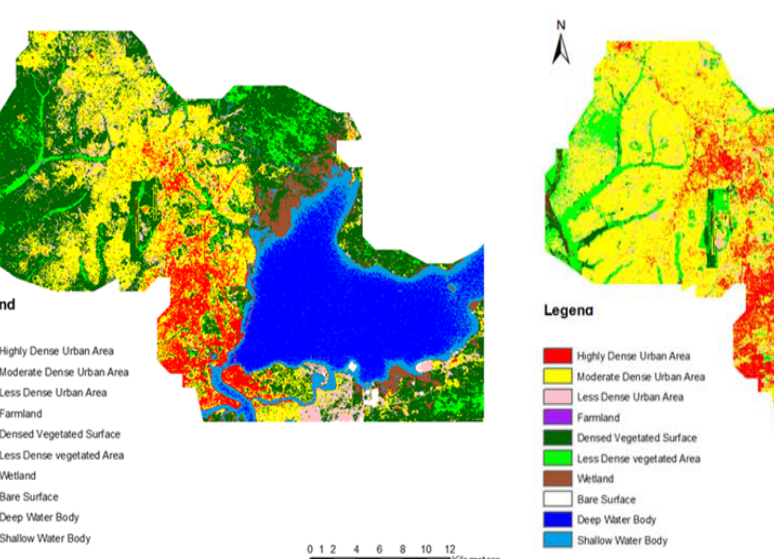
Fig. 3: Land cover classification for the nine local government areas (2013)